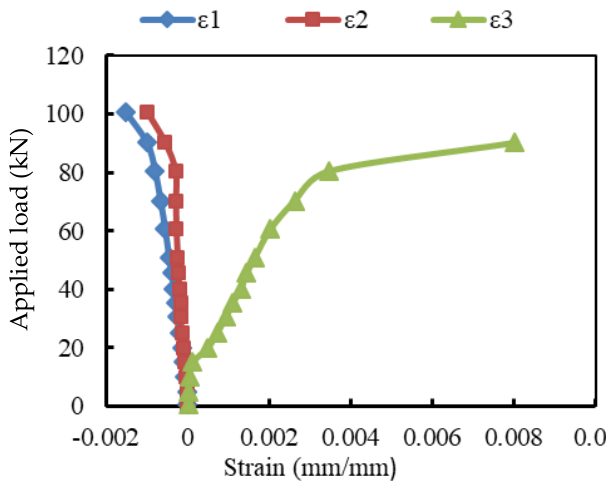
Figure 7. Load- strain relationship at mid-span of beam Ref.